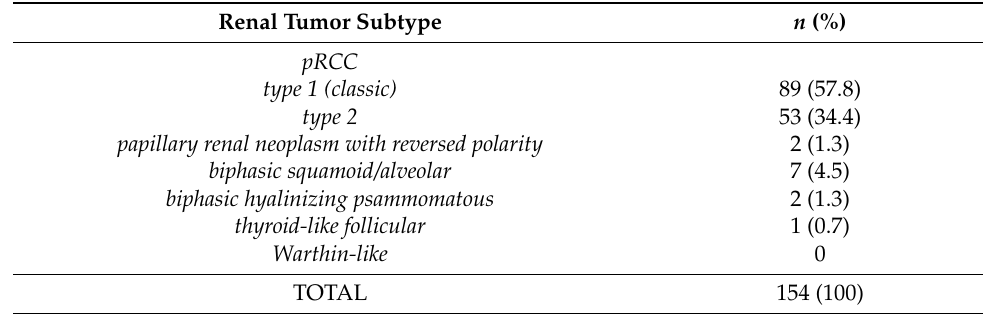
Table 2. Prevalence of papillary RCC in a consecutive single-institution cohort (cohort #1) after exclusion of 2016 WHO classification-recognized RCC types (e.g., translocation family RCC, ccpRCC, unclassified RCC, MTSC RCC, FH-deficient RCC and